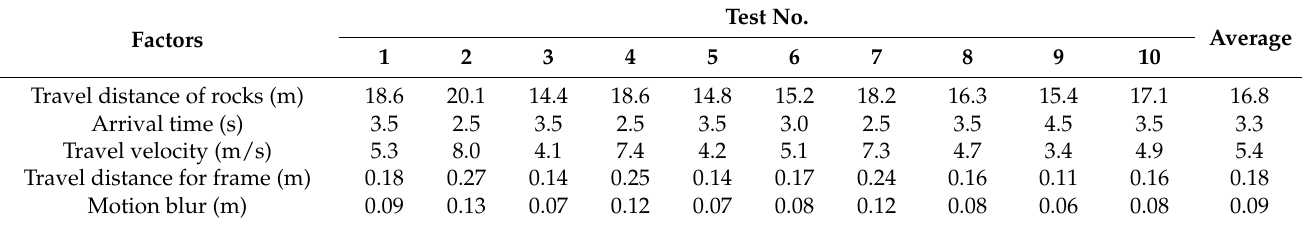
Table 1. Results of rockfall tests [21].